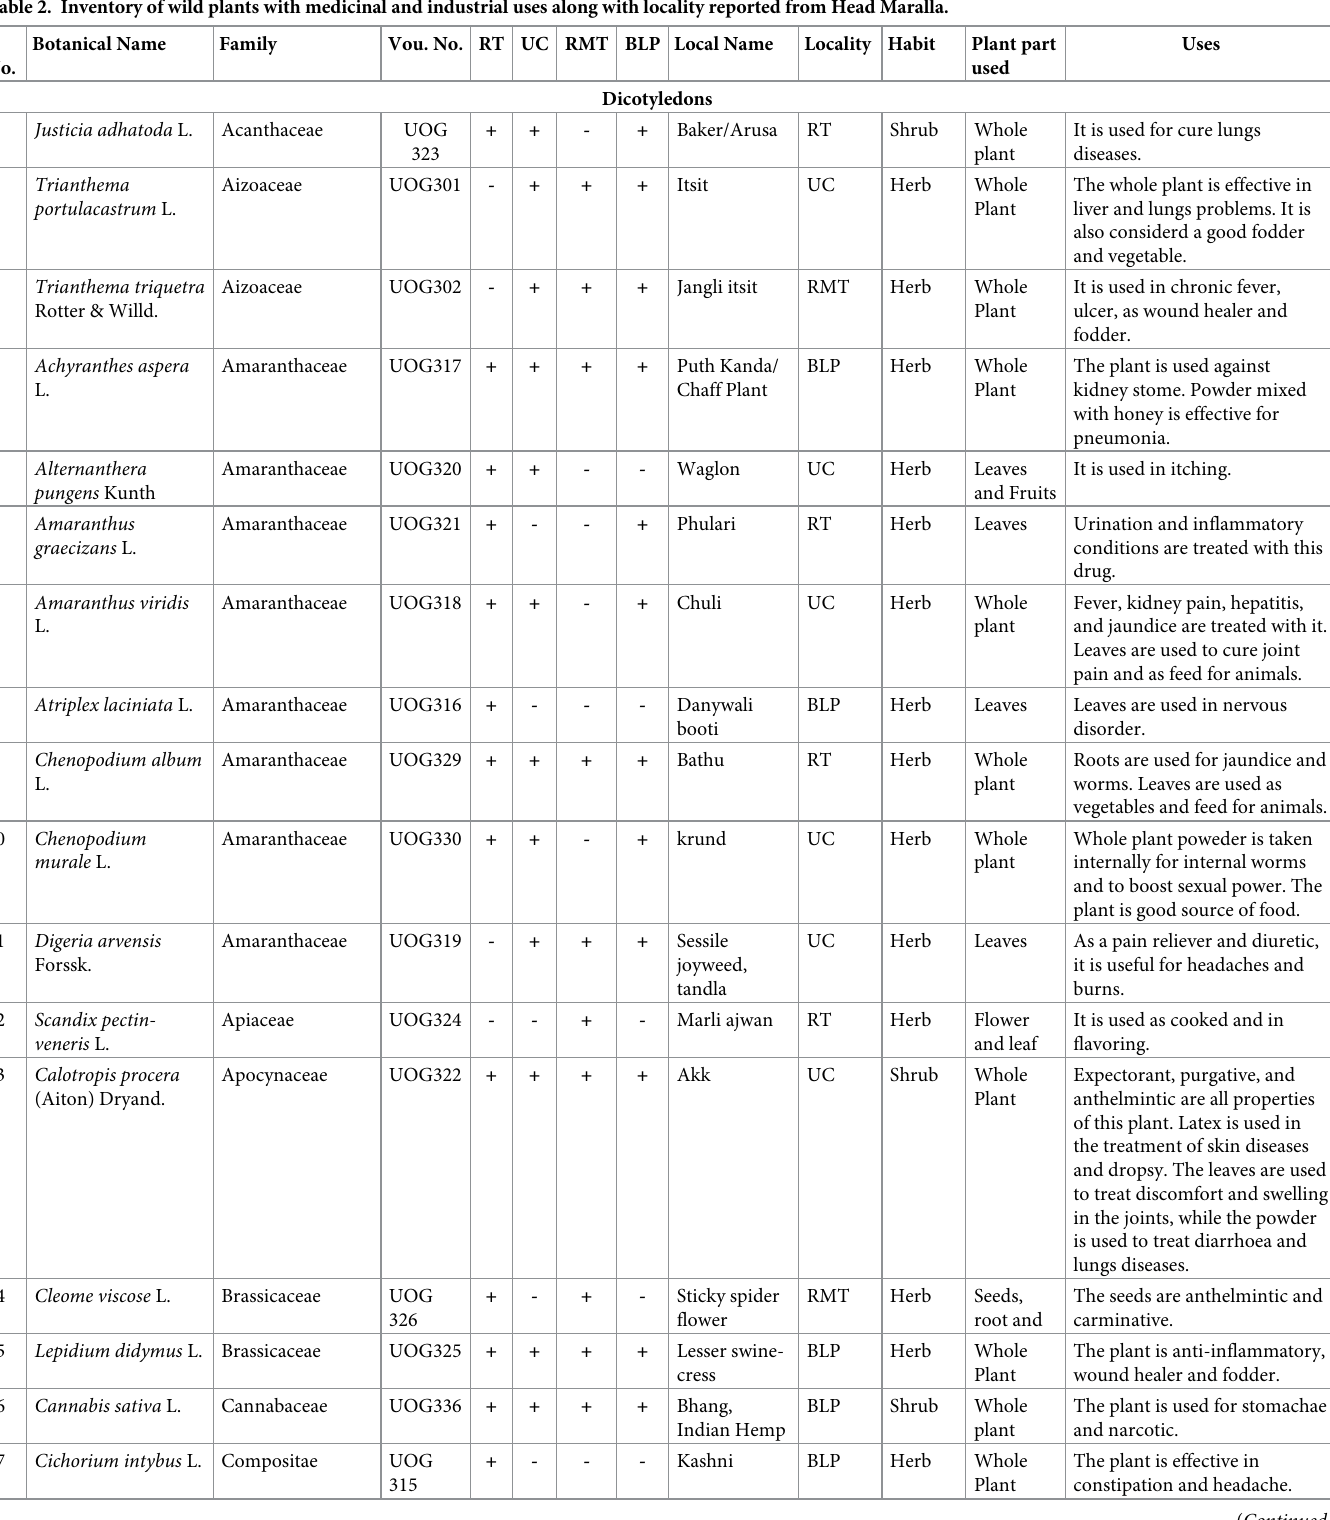
Table 2. Inventory of wild plants with medicinal and industrial uses along with locality reported from Head Maralla. S. Botanical Name Uses No.